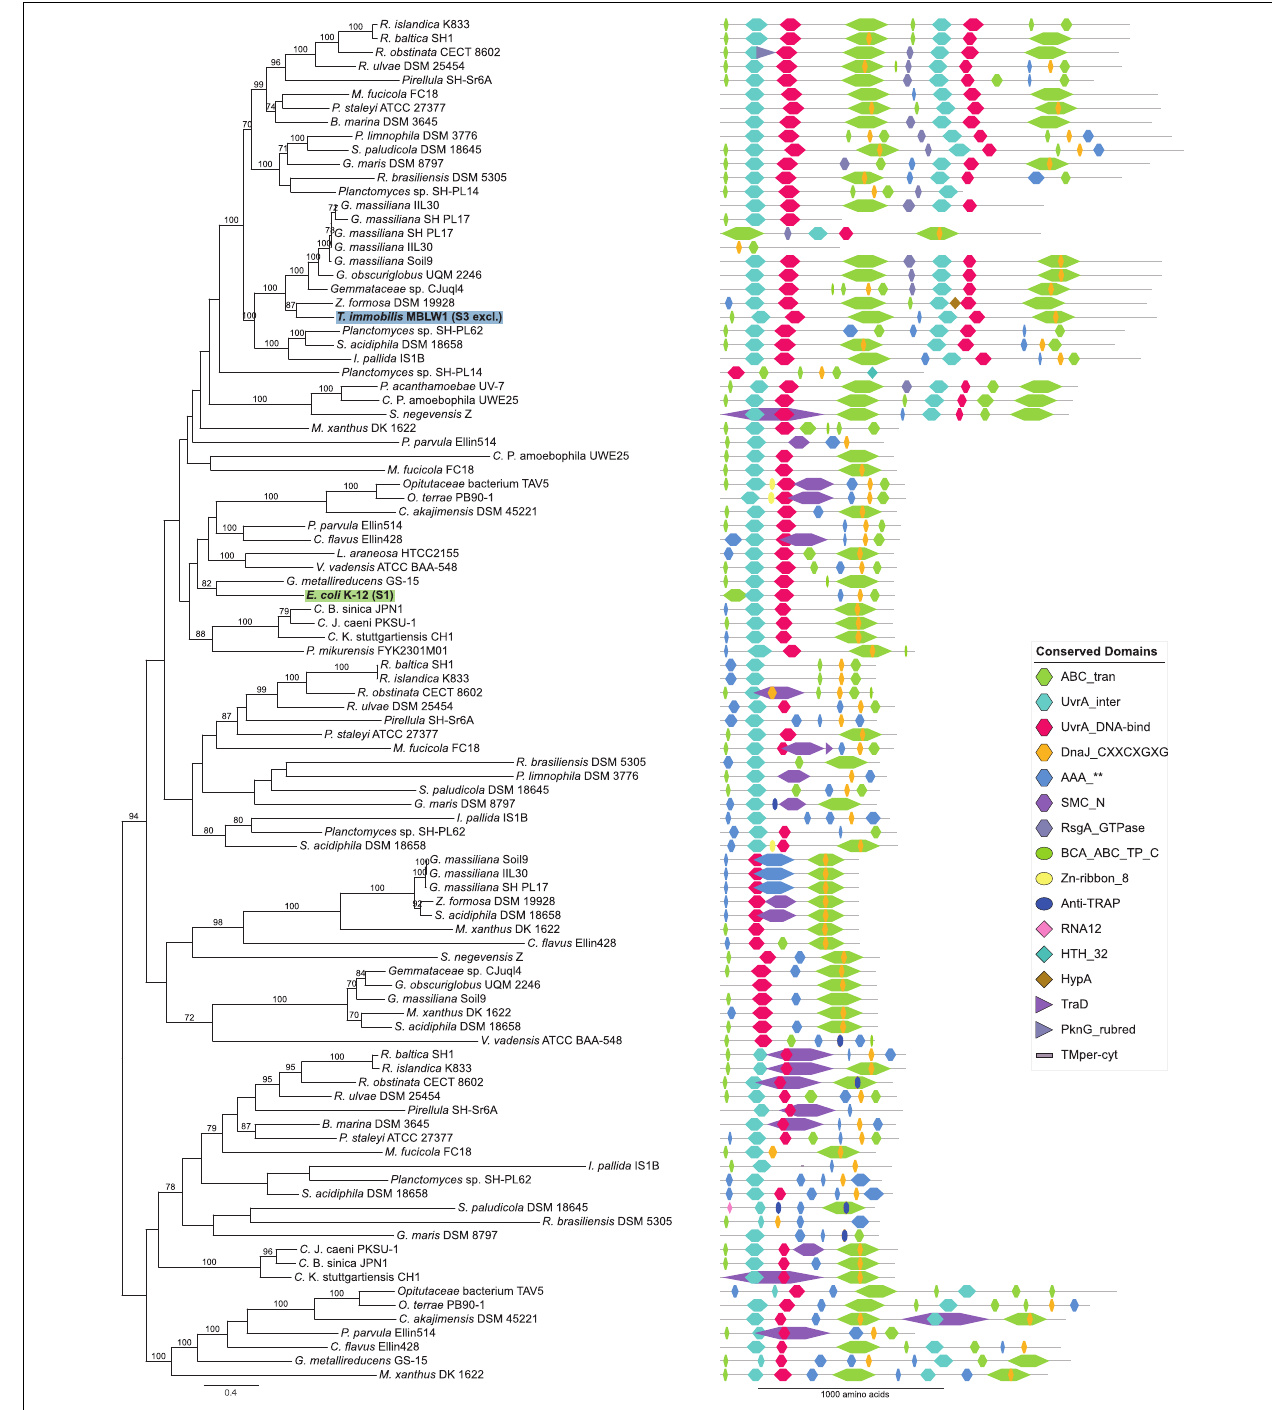
FIGURE 13 | Phylogeny and domain architecture of UvrA in Planctomycetes and other bacteria. The species names of the proteins expressed in the subcellular fractionation assay are shown in bold. The corresponding subcellular fractions are mentioned in parenthesis and further highlighted by colored boxes [green: Tris (S1), blue: SDS (S3)]. Signal peptides and transmembrane domains were annotated using SignalP-5.0b and Phobius 1.01. Conserved domains were assigned to the proteins using the pfam_scan.pl script with a minimum sequence-evalue of 0.01 and the Pfam 32.0 database. The proteins were aligned using the mafft-linsi alignment algorithm in MAFFT v7.310, and a maximum likelihood phylogeny was inferred using LG + (cid:48) amino acid substitution model with 100 bootstraps in RAxML version 8.0.26. Bootstrap values below 70 are not shown.